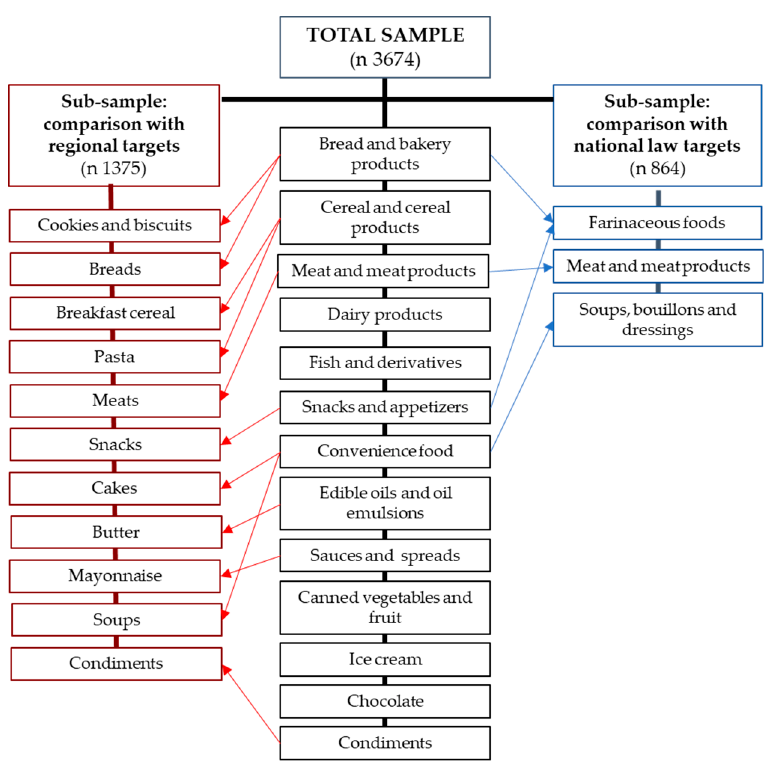
Figure 1. Food groups included in the total sample and their relationships with food groups whose maximum sodium levels are set by national law and regional targets.